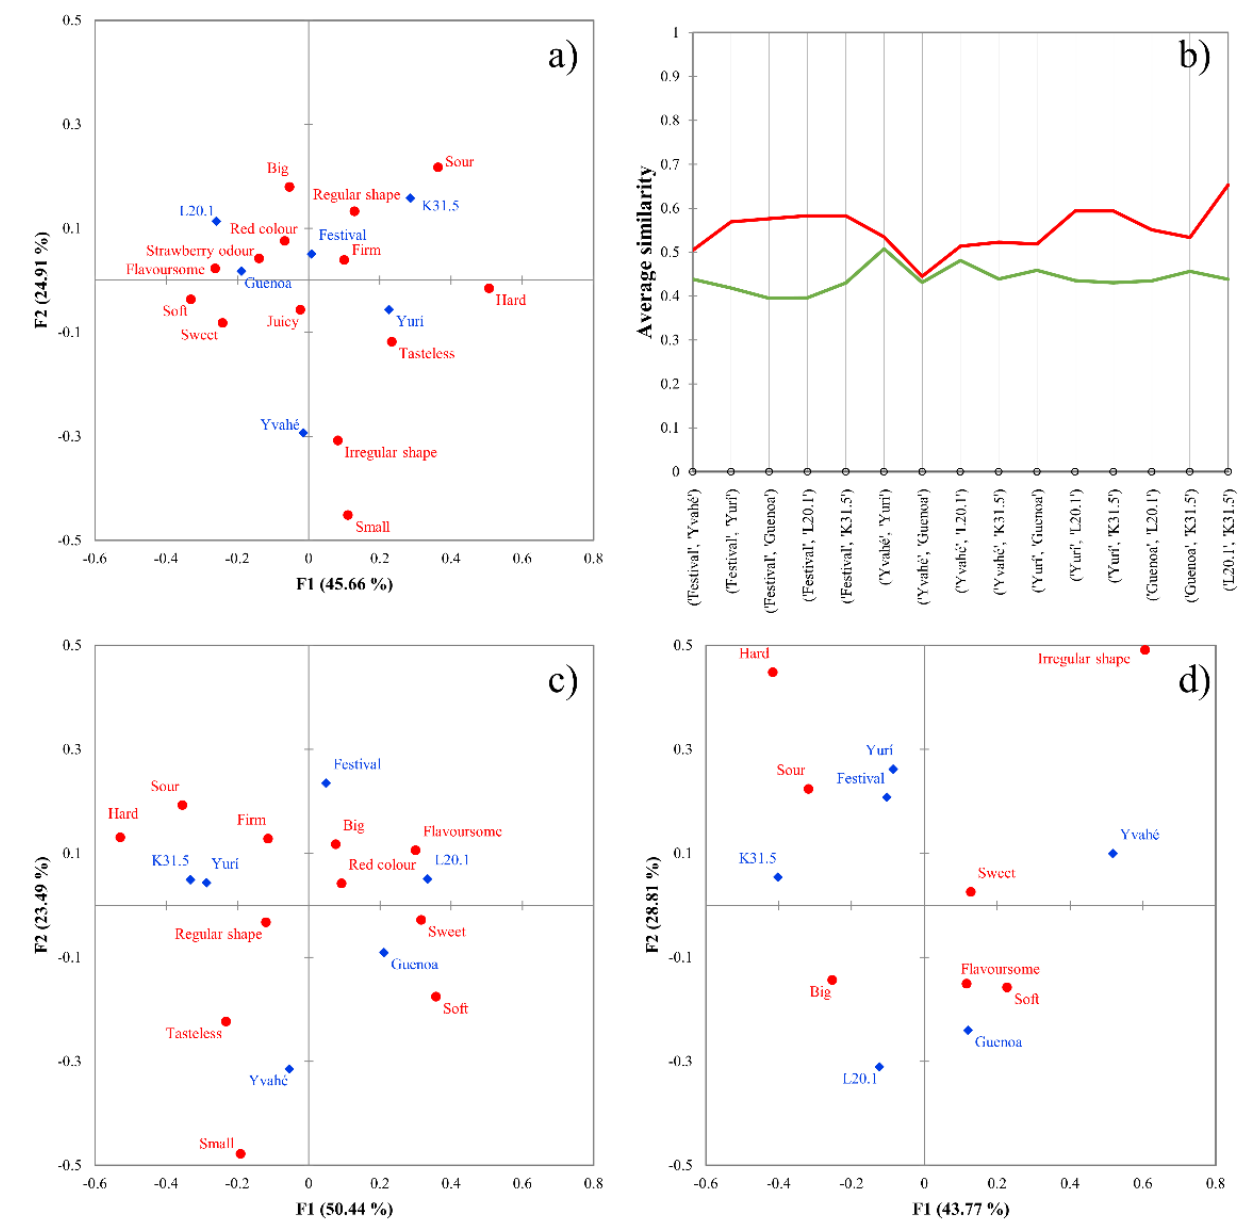
Figure 5. ( a – d ) Results of the strawberry dataset. Correspondence analysis of the total sample (n = 117). ( a ), profile plot of the agglomerative hierarchical cluster analysis with Euclidean distance and Ward’s method ( b ), correspondence analysis of good discriminators (n = 81) ( c ), correspondence analysis of poor discriminators (n = 35) ( d ). Varieties are marked with blue dots, attributes are marked with red squares in panels ( a ), ( c ), and ( d ), cluster of good discriminators is colored by green, while poor discriminators are colored by red in panel ( b ).